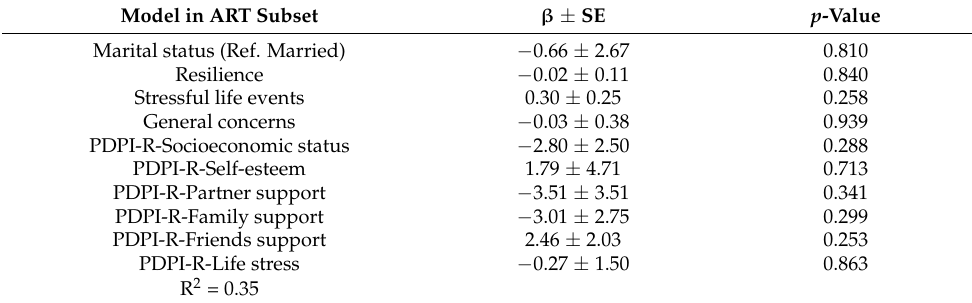
Table 5. Generalized regression models associated with PHQ-9 scale in the subset of ART